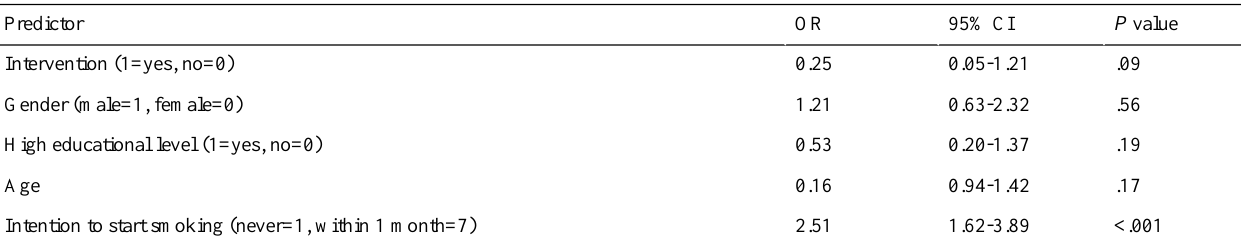
Table 3. Predictors of smoking initiation at 6-month follow-up.